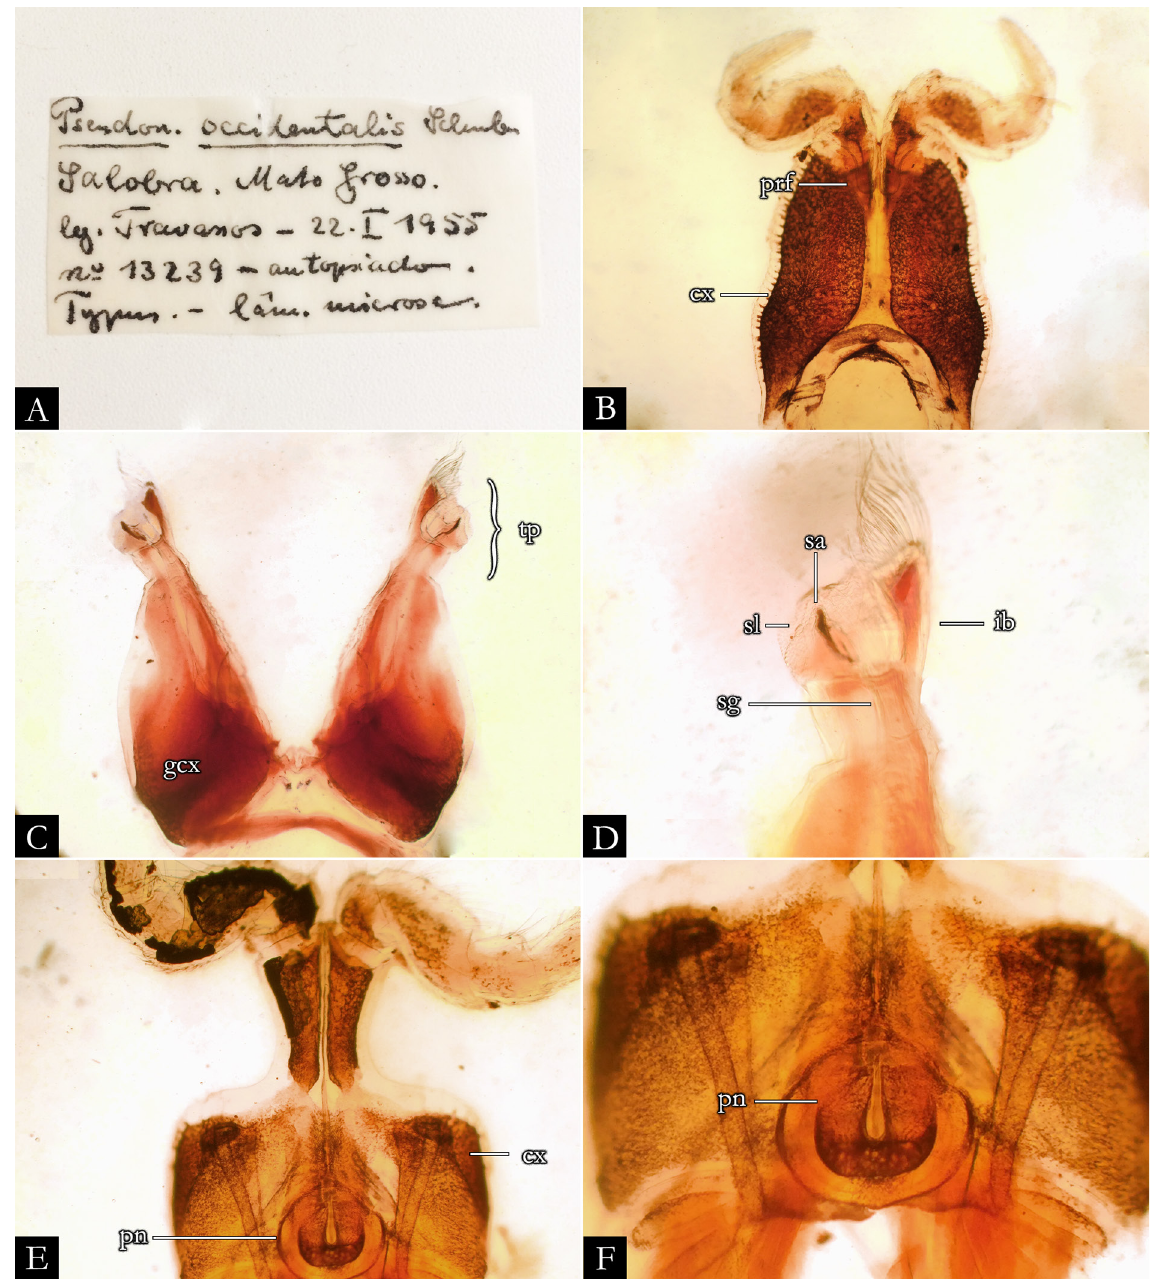
Fig. 100. Pseudonannolene occidentalis Schubart, 1958, holotype, ♂ (MZSP). A . Original label of type material mounted on microscope slide. B . First leg-pair. C . Gonopods, in oral view. D . Detail of telopodites, in oral view. E . Second leg-pair. F . Detail of penis. Abbreviations: see Material and methods. Images not to